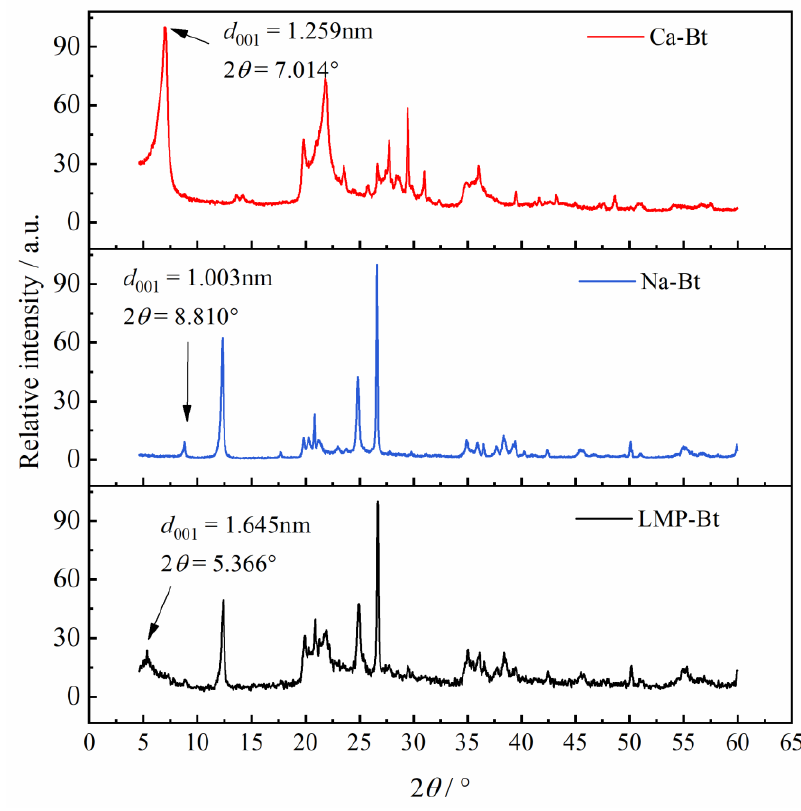
Figure 2. X-ray diffraction results of Ca-Bt gel, Na-Bt gel and LMP-Bt gel.